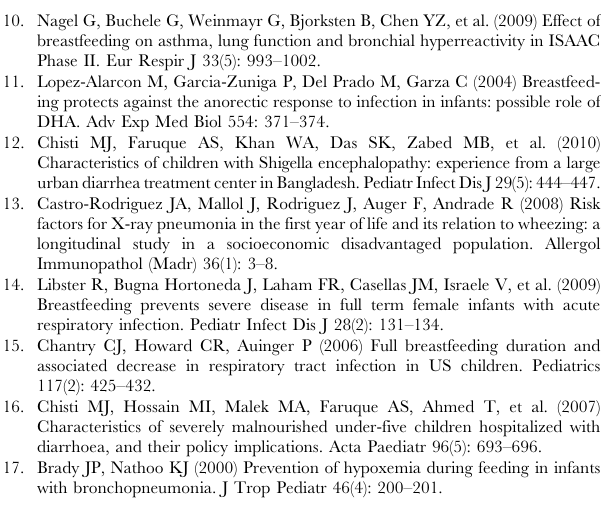
Figure represents n (%), unless specified otherwise.